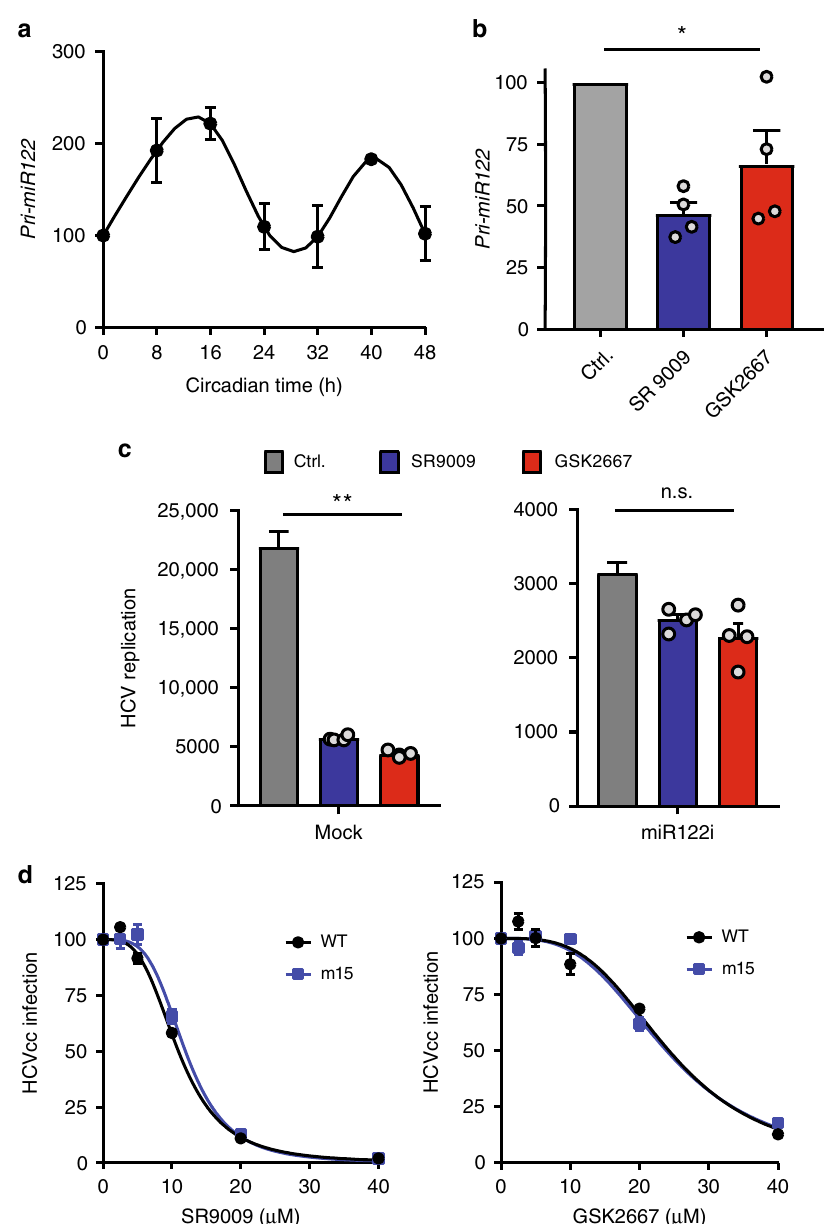
Fig. 4 REV-ERB agonists modulate miR-122. a Pri-miR122 displays circadian pattern in synchronised Huh-7 cells. qRT-PCR analysis of pri-miR-122 levels relative to GAPDH in cycling Huh-7 cells (mean ± S.E.M., n = 3). b REV-ERB agonists reduce pri-miR122 levels. qRT-PCR analysis of pri-miR-122 relative to GAPDH in Huh-7 cells treated with REV-ERB agonists (20 μ M) for 16 h (mean ± S.E.M., n = 3, Kruskal – Wallis ANOVA with Dunn ’ s test). c Anti-viral activity of REV-ERB agonists is miR-122 dependent. Huh-7 cells were electroporated with HCV JFH-Luc and miR-122 antagonist (100 pM per 10 6 cells) or a randomised control, allowed to recover for 4 h and treated with REV-ERB agonists (20 μ M) for 24 h. Hepatitis C virus (HCV) replication was assessed by measuring luciferase activity and the data expressed relative to Ctrl untreated cells (Mean ± S.E.M., n = 4, Kruskal – Wallis ANOVA with Dunn ’ s test). d REV-ERB agonists inhibit HCV independent of direct miR-122 binding. Huh-7 cells were inoculated with WT or miR122 independent HCV (m15) for 6 h, unbound virus removed by washing and the infected cells treated with SR9009 or GSK2667 for 48 h and the frequency of NS5A expressing cells quanti fi ed and expressed relative to untreated (Ctrl) cells (mean ± S.E.M., n =